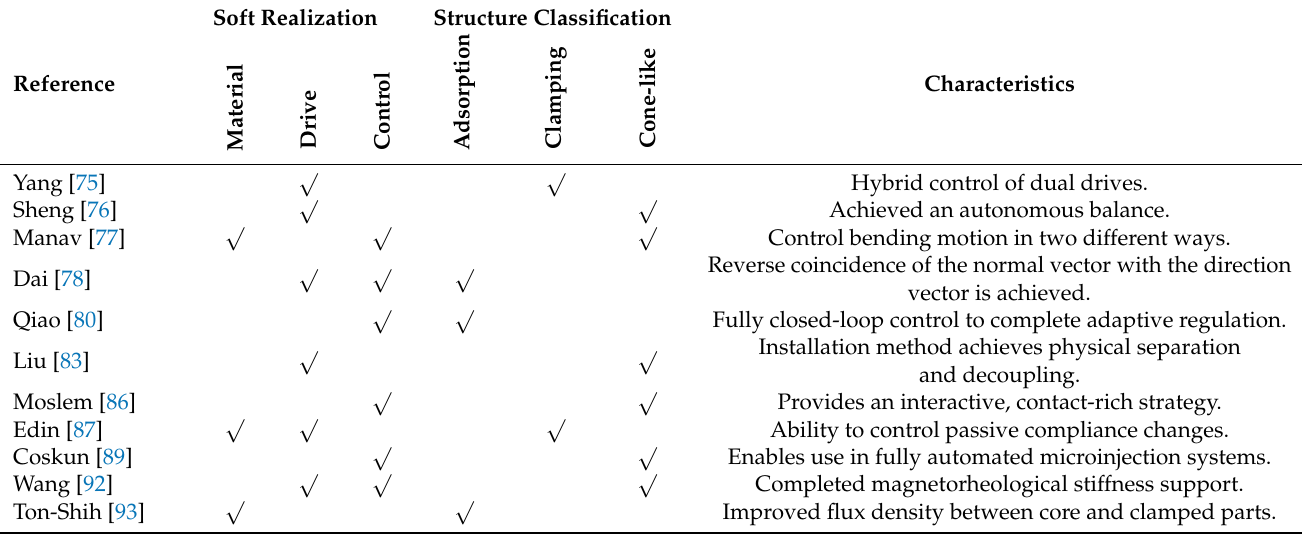
Table 2. Summary of innovative structural design results of hybrid flex control